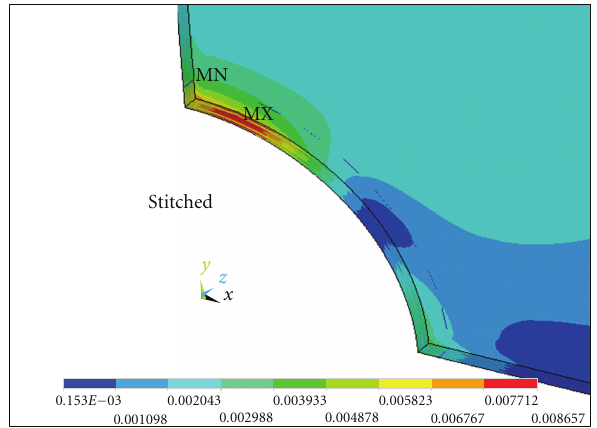
the e ff ect of stitching on the fracture response of single- lap composite joints by means of link element model.